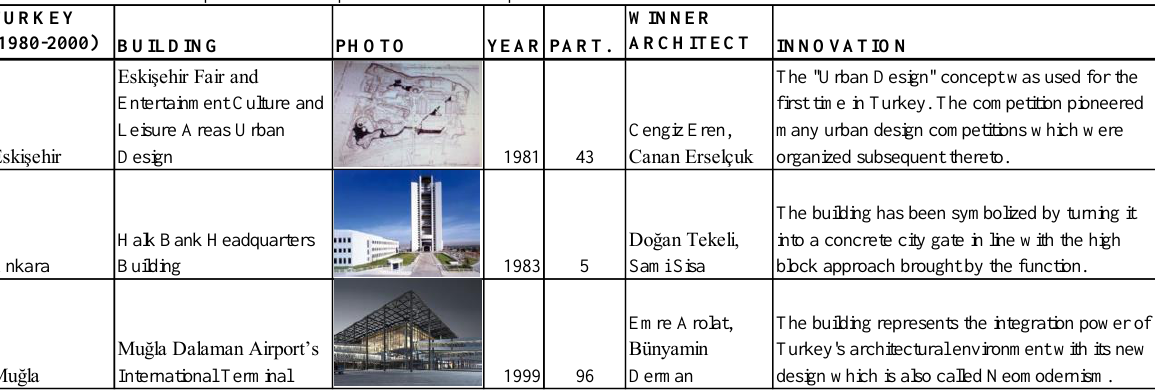
Table 8 . Selected competition examples of 1980-2000 period T UR K E